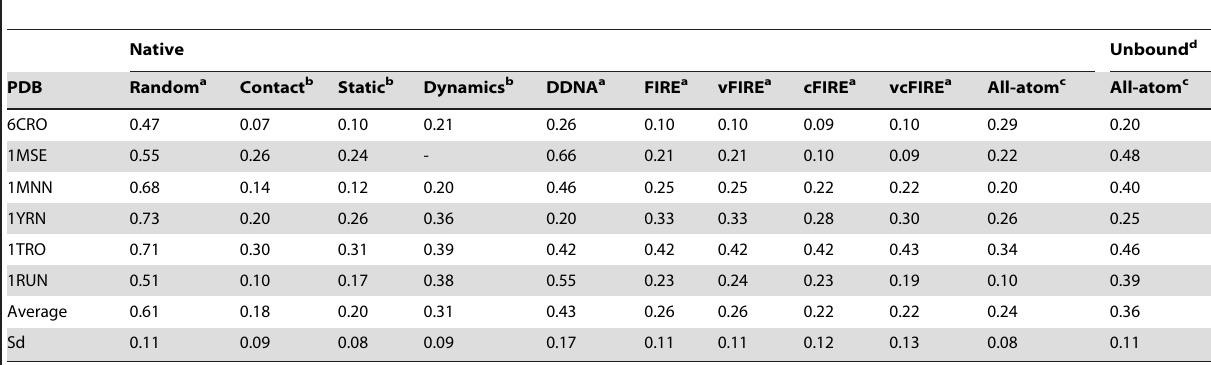
Table 3. Predictions using unbound structures compared with those using native complexes.